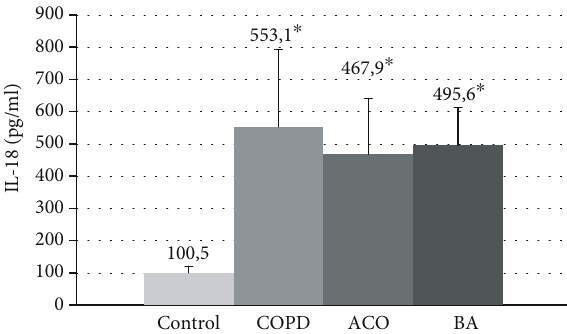
Figure 4: The mean IL-18 concentrations in the blood serum in patients with COPD, asthma-COPD overlap, and bronchial asthma. COPD: chronic obstructive pulmonary disease; ACO: asthma-COPD overlap; BA: bronchial asthma; ∗ p < 0 : 05 versus healthy